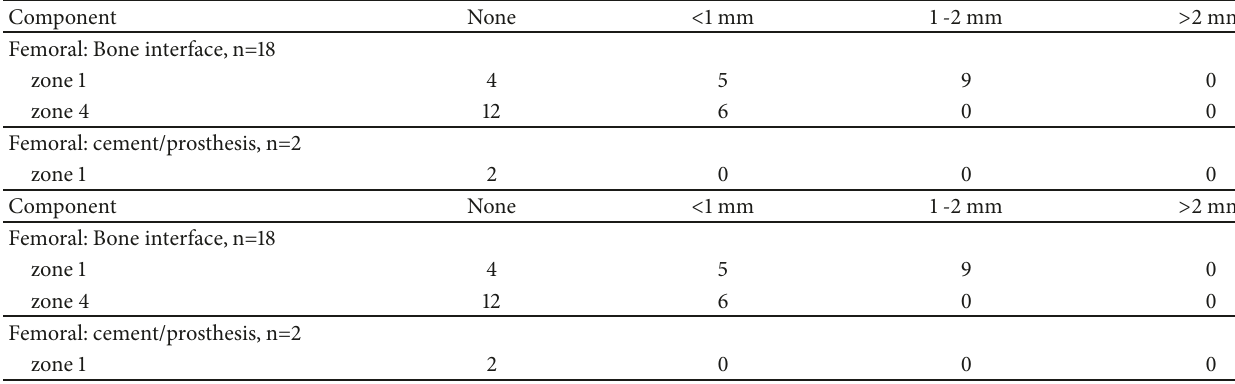
Table 8: The proportion of radiolucent line widths per femoral zone.